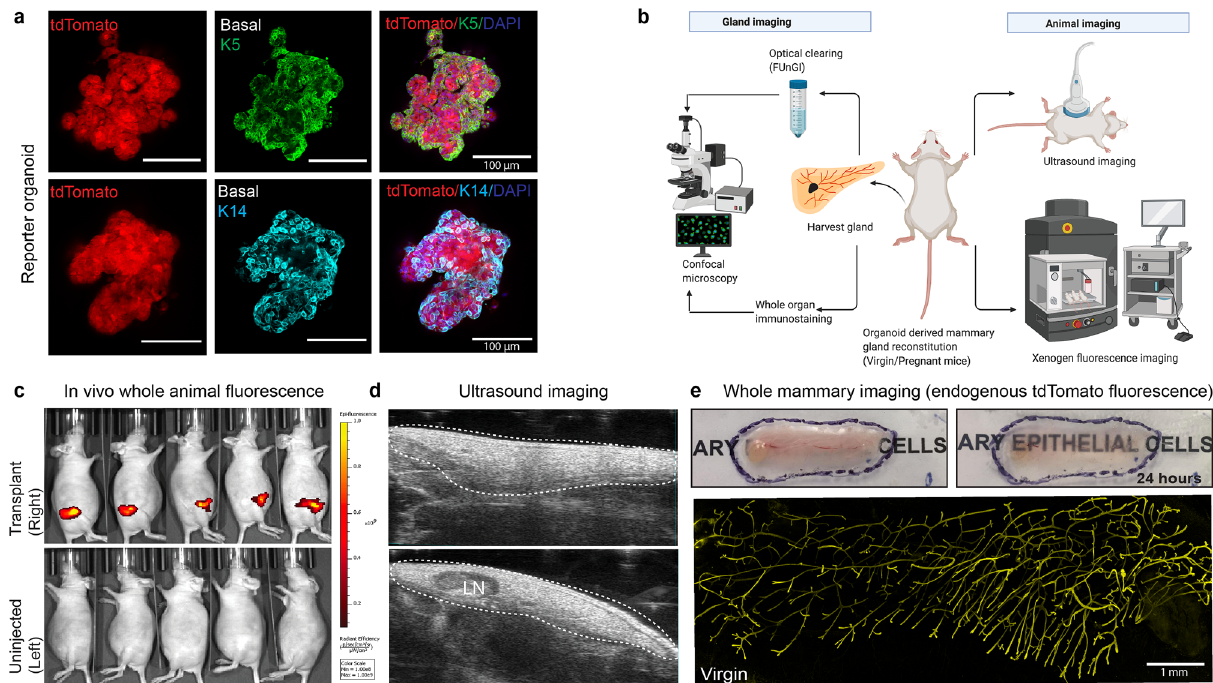
Figure 3. Imaging modality to whole animal in vivo fluorescence. ( a ) Immunofluorescent staining showing the expression of basal epithelial marker (K5 and K14) in mammary organoids generated from Rosa26 tdTomato mammary gland. The Red fluorescence is tdTomato endogenous fluorescence (Scale bar = 100 µm). ( b ) Schematic showing imaging modalities to whole gland imaging and whole animal imaging. Animals were anaesthetized after 4 weeks post transplantation and imaged for tdTomato fluorescence at the left side (site for transplantation) and also checked for mammary fatpad imaging through ultrasound imaging. The mammary glands were dissected out and checked for the endogenous tdTomato fluorescence to visualize ductal trees, and also performed whole-gland immunostaining to check tdTomato-derived mammary epithelial cells. ( c ) In vivo whole animal fluorescence (Xenogen IVIS fluorescence imager) reveals tdTomato expression at the site of transplantation. The right side was used as control (n = 5 pregnant mice). The Radiant efficiency scale in the whole animal fluorescence is expressed as (p/sec/cm 2 /sr)/(µW/cm 2 ). Color scale: Min = 1.00e 8 and Max = 1.00e 9 . ( d ) Ultrasound imaging reveals the formation of mammary fat pad and complete absence of the lymph node (LN) confirming efficient mammary fat pad clearing and the ability of mammary organoids to reconstitute mammary gland (n = 5 pregnant mice). ( e ) Tissue clearing enables 3D confocal imaging to visualize mammary ductal tree formation. The mammary glands were surgically dissected after 4 weeks post transplantation (virgin) and incubated in Fructose-Glycerol clearing Solution (FGCS) for 24 h, making the whole tissue translucent for efficient imaging. Tissue clearing can also be performed for 3–7 days (Pregnant mice) depending on the stage of mammary gland development. Confocal microscopy of the whole gland was subsequently imaged to check for the presence of ductal trees, and the endogenous tdTomato fluorescence confirms organoids are able to regenerate mammary gland ductal tree in vivo (Scale bar = 1